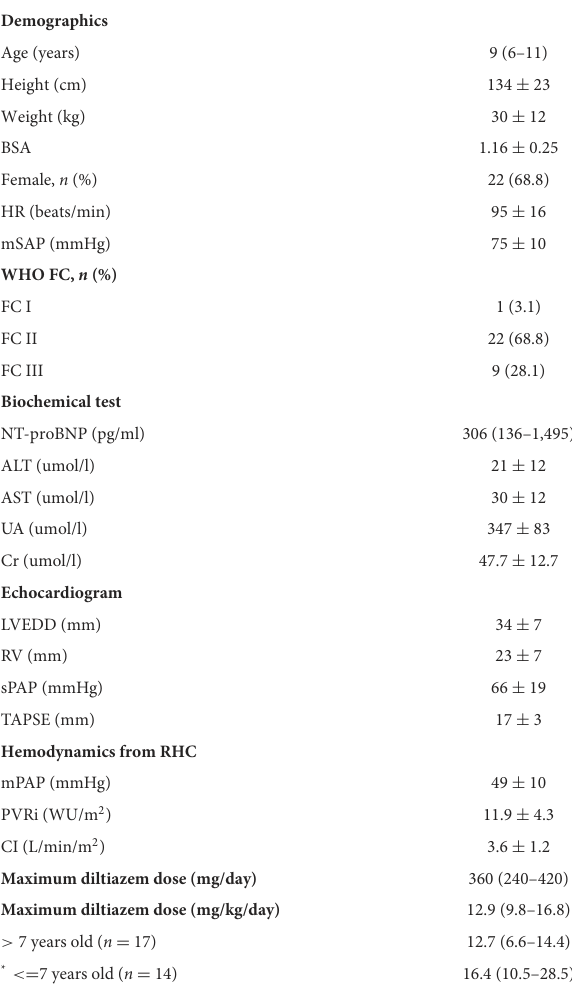
TABLE 1 Baseline clinical characteristics of